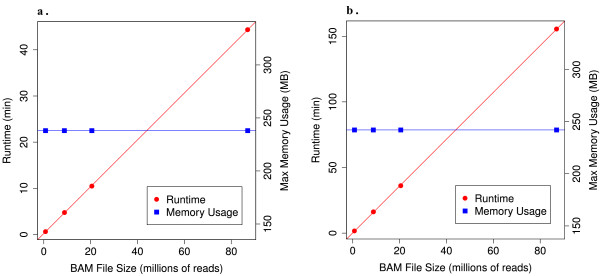
Computational resources. Both Atlas-SNP2 (a.) and Atlas-Indel2 (b.) were tested on a series of BAM files to evaluate run time and maximum memory usage. The algorithm for both applications is designed so that runtime increases linearly with the number of reads analyzed, while memory usage is approximately constant, based on the size of the reference genome.